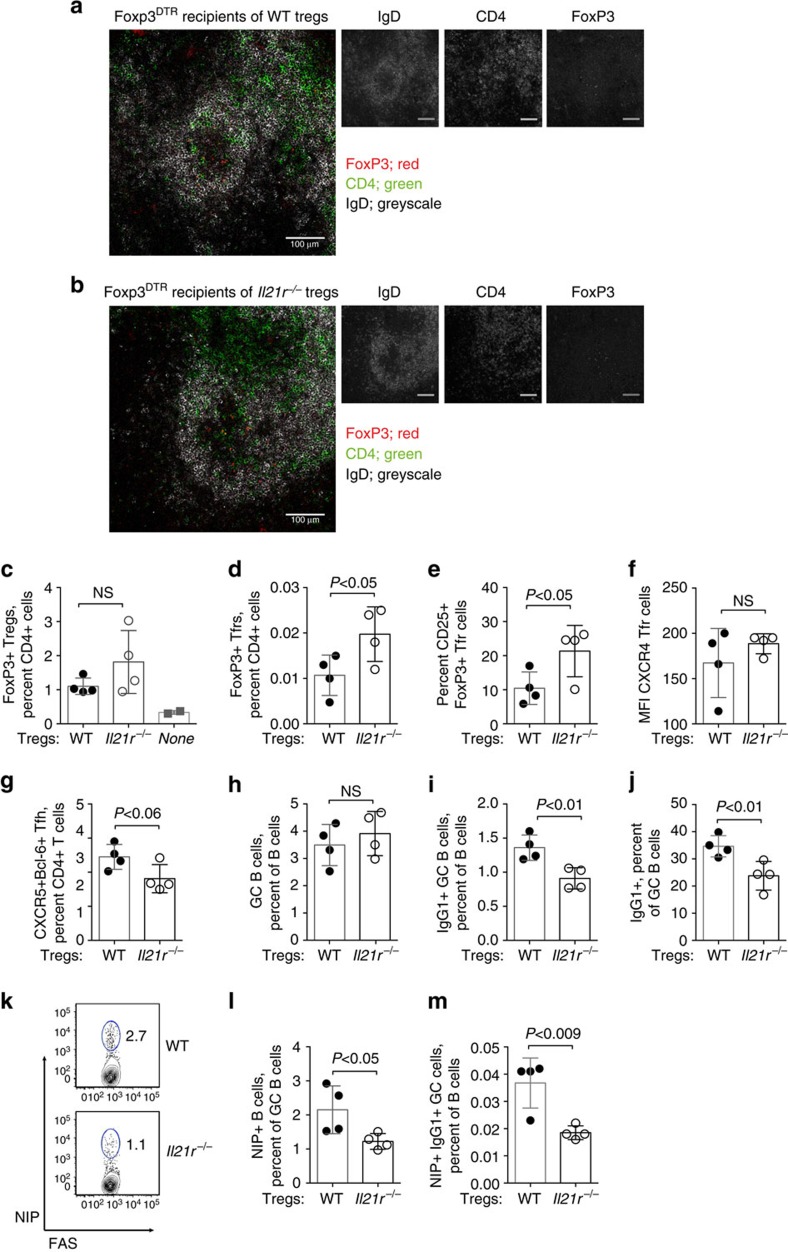
IL-21:IL-21R interactions on Treg cells reduce antigen-specific B-cell responses.FoxP3DTR recipients depleted of FoxP3+ cells on days −1 and 4 of immunization received CD4+ Treg cells purified from the spleens of Il21r−/− and WT mice before immunisation with NP-OVA adsorbed to alum. Localization of (a) FoxP3+
Il21r−/− and (b) FoxP3+ WT Tfr cells within GCs of the spleens of Foxp3DTR mice on day 10 of immunization. Histological sections of spleen were immunostained for IgD+ non-GC B cells (grey scale), FoxP3 (red) and CD4 (green). Individual antibody immunostains are shown in grey scale. Scale bars, 100 μm. Immunostaining and flow cytometric analyses on day 10 of NP-OVA immunization identified (c) FoxP3+ CD4+ Treg cells shown as a percentage of CD4+ T cells in Foxp3DTR mice that received either WT, Il21r−/− or no FoxP3 Treg cells (d) FoxP3+ CXCR5+ PD-1+ CD4+ Tfr cells as a percentage of CD4+ T cells, (e) the percentage of CD25-expressing cells within the Tfr population, (f) the mean fluorescence intensity of CXCR4 immunostaining on Tfr cells and (g) CXCR5hi Bcl-6+ Tfh cells. Analyses of the GC B-cell populations from the same mice showing the (h) percentage of FAS+ GL7+ GC B cells (i) IgG1+ GC B cells as percentage of B cells and (j) IgG1+ B cells as a percentage of the GC B cell population. (k) Flow cytometry dot plots showing gating for NP-specific FAS+ GC B cells, the (l) percentages of NP-specific (NIP+) GC B cells and (m) NP-specific IgG1+ GC B cells as a percentage of B cells. Data are shown as mean ±s.d., n=4 mice with two experimental replicates. P-values were determined by Student's t-test, P-values >0.05 were deemed not significant (NS).